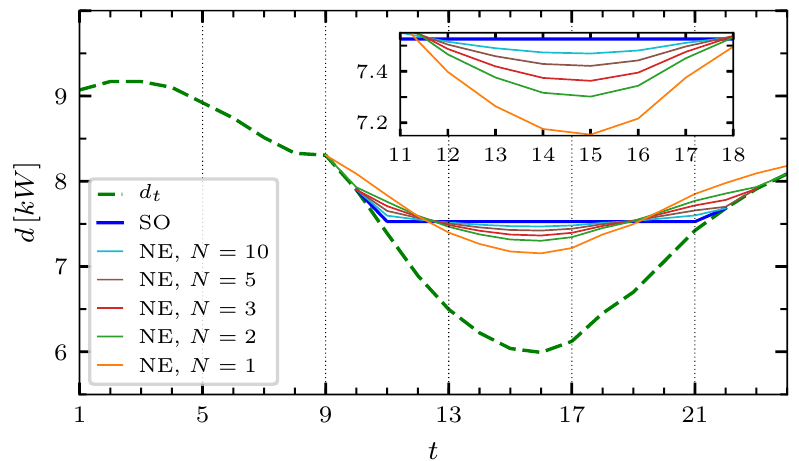
Figure 3. Examples of Nash equilibria of the game G for different numbers N of identical players. The thick blue curve corresponds to the (valley-filling) social optimum and is reached in the limit N → ∞ . Details about the game settings are discussed in Section 7; however, with the following differences: (a) the game evolution is deterministic, and follows the non-PEV demand curve d ( 1 ) introduced in Section 7; (b) players are homogeneous, and their parameters are equal to those of players 1–5 in the numerical example of Section